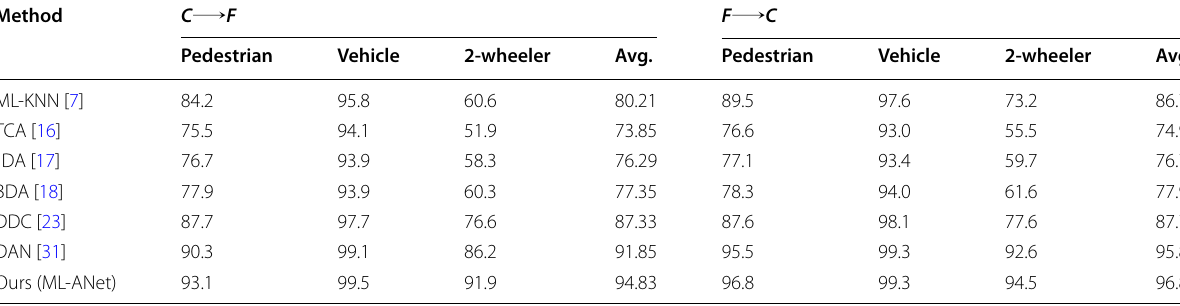
Table 3 Comparison of classification accuracies (%) on Cityscapes and Foggy Cityscapes datasets Method C ⟶